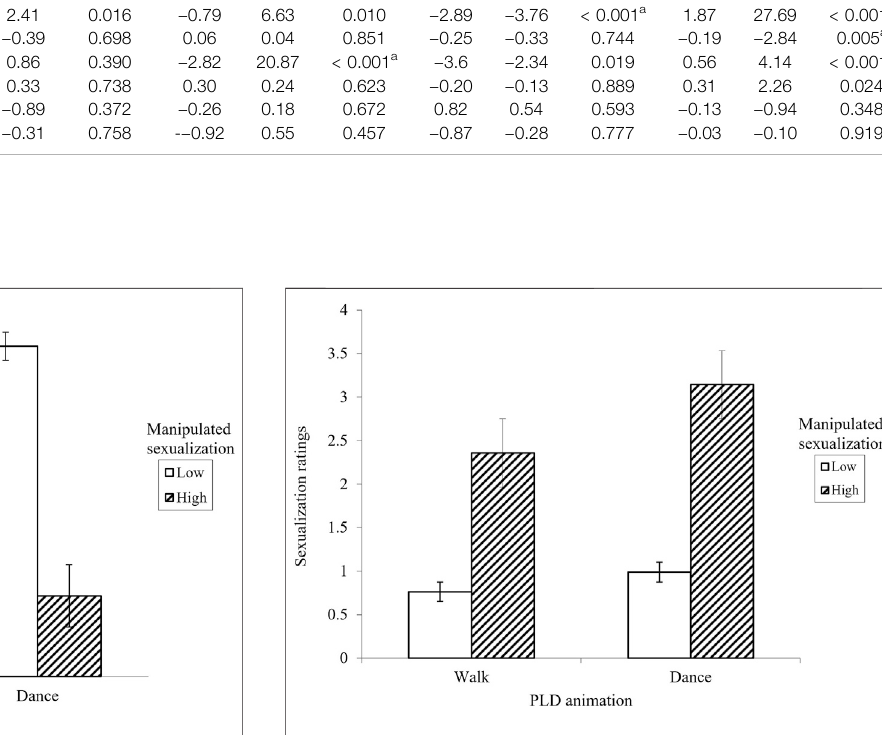
FIGURE 3 | Sexualization ratings (with 95% con fi dence interval) of PLD movement animation by level of manipulated